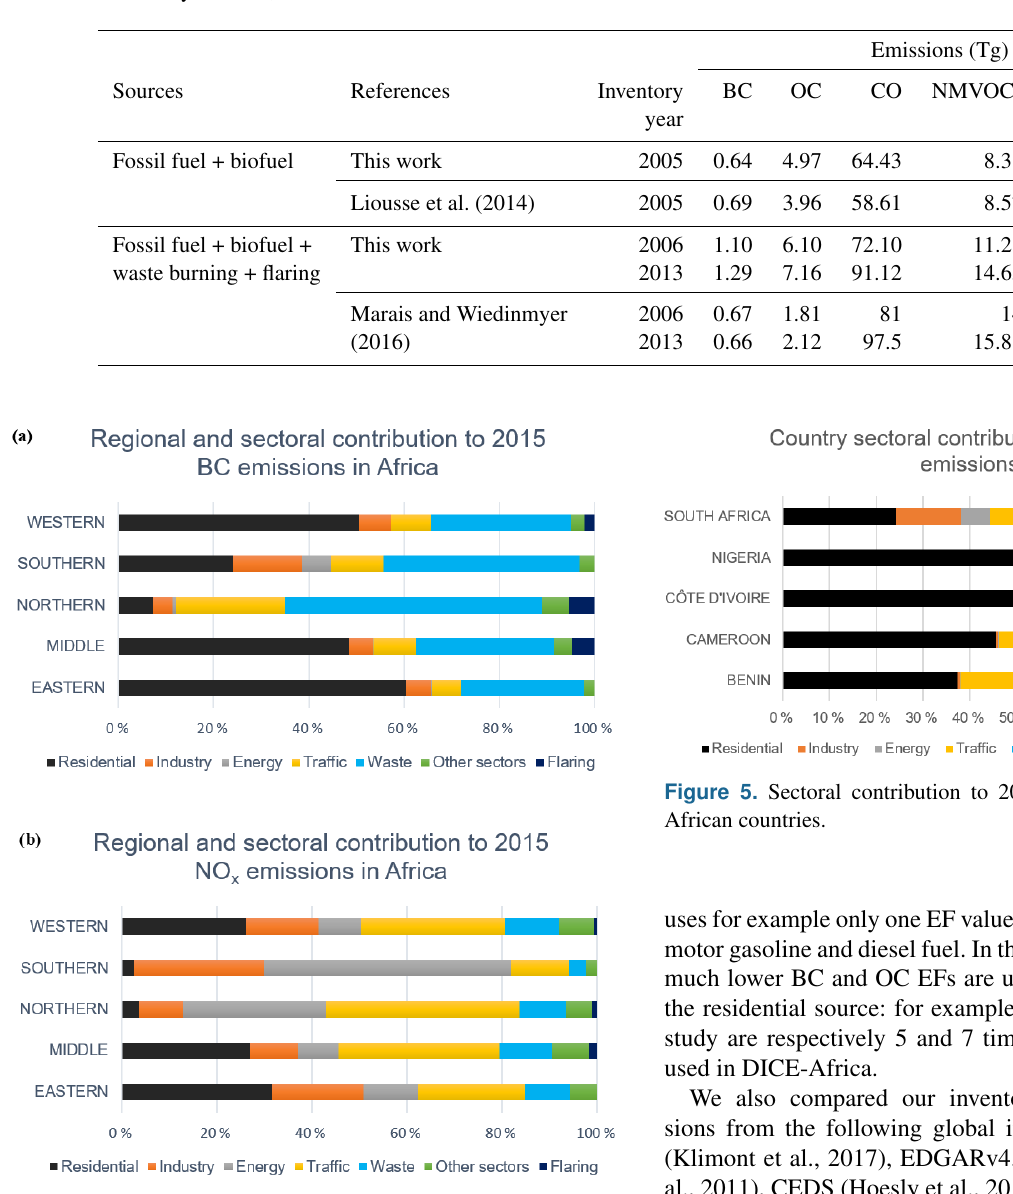
Figure 4. Regional sectoral contribution to 2015 BC (a) and NO x (b) emissions in Africa.